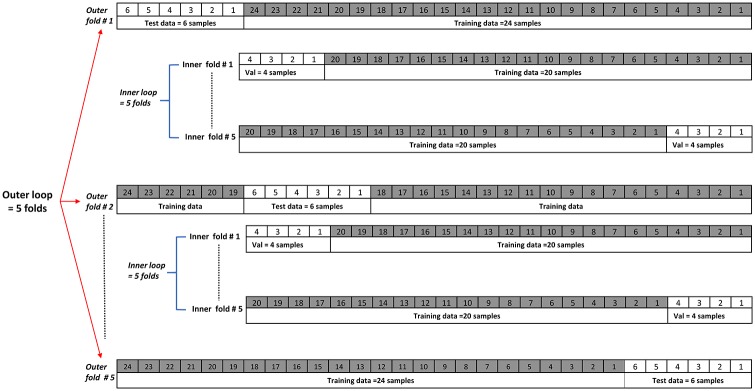
Nested k-fold cross validation with K = 5.